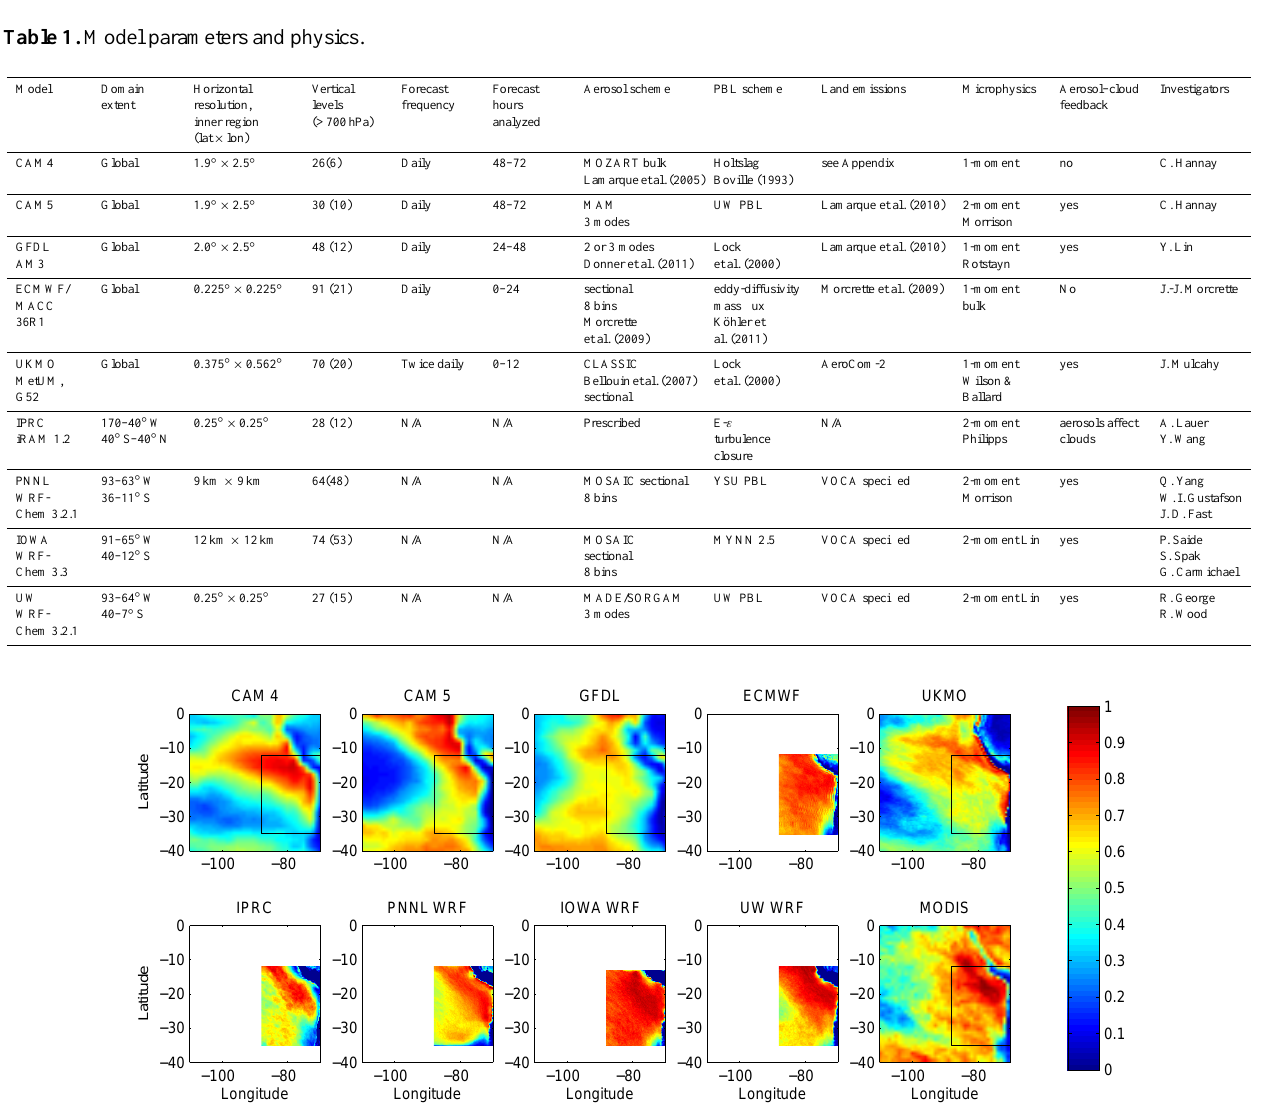
Figure 2. Models’ mean low cloud fractions at 10:30LT (15:30UTC) compared with MODIS Terra daytime mean total cloud fraction. The extent of the inner VOCA study region is shown with a black